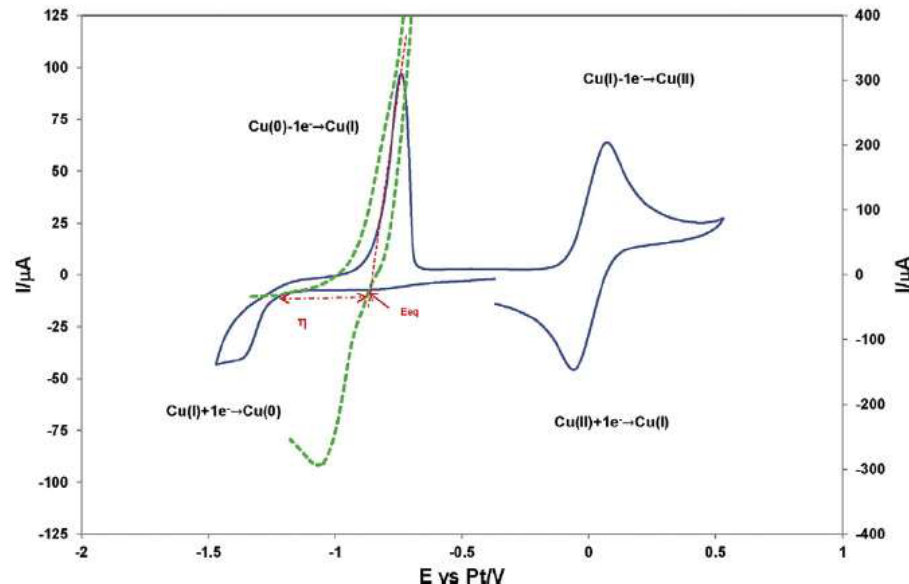
Figure 2. Cyclic voltammogram for Cu deposition on a Pt electrode exhibiting a nucleation overpotential (green); Cyclic voltammogram obtained on a Pt electrode in the [bmim]Cl without Cu(I) (blue). Reproduced with permission from [33], copyright 2016, Elsevier.